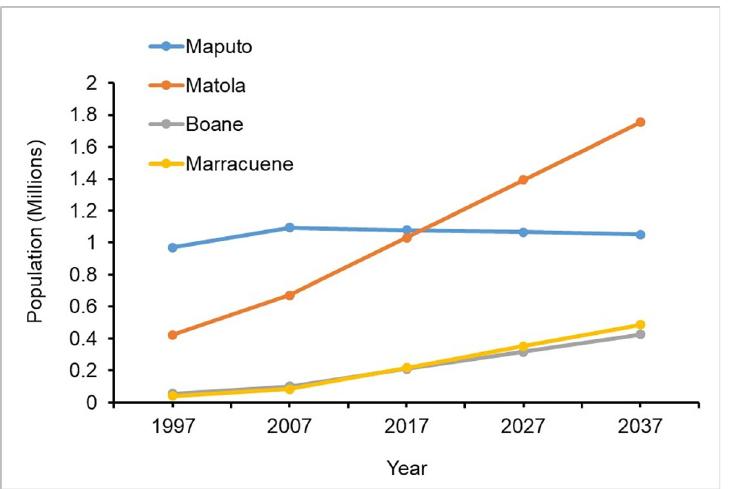
Fig 5. Past and future population growth, from 1997 to